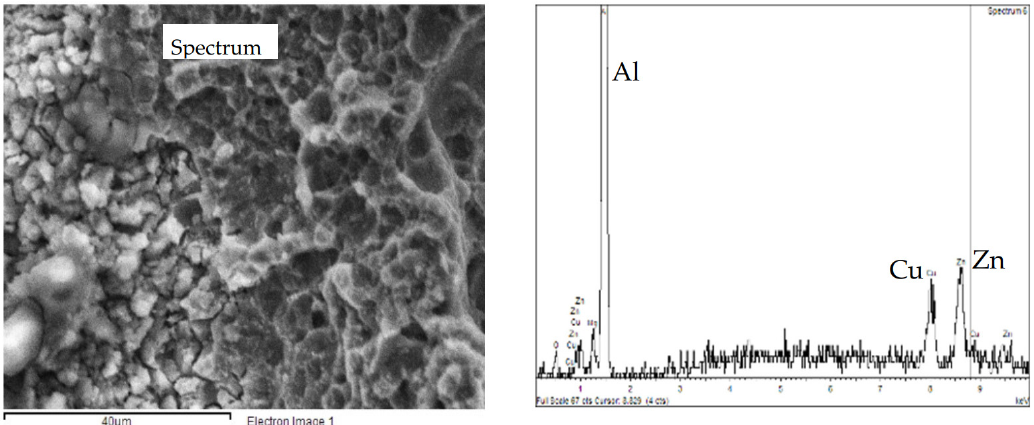
Figure 20. EDS spectrum of the precipitates present on the mixed ductile/brittle zone of the fracture surface of the FWS specimen after the SSR test in 0.6 M NaCl solution.